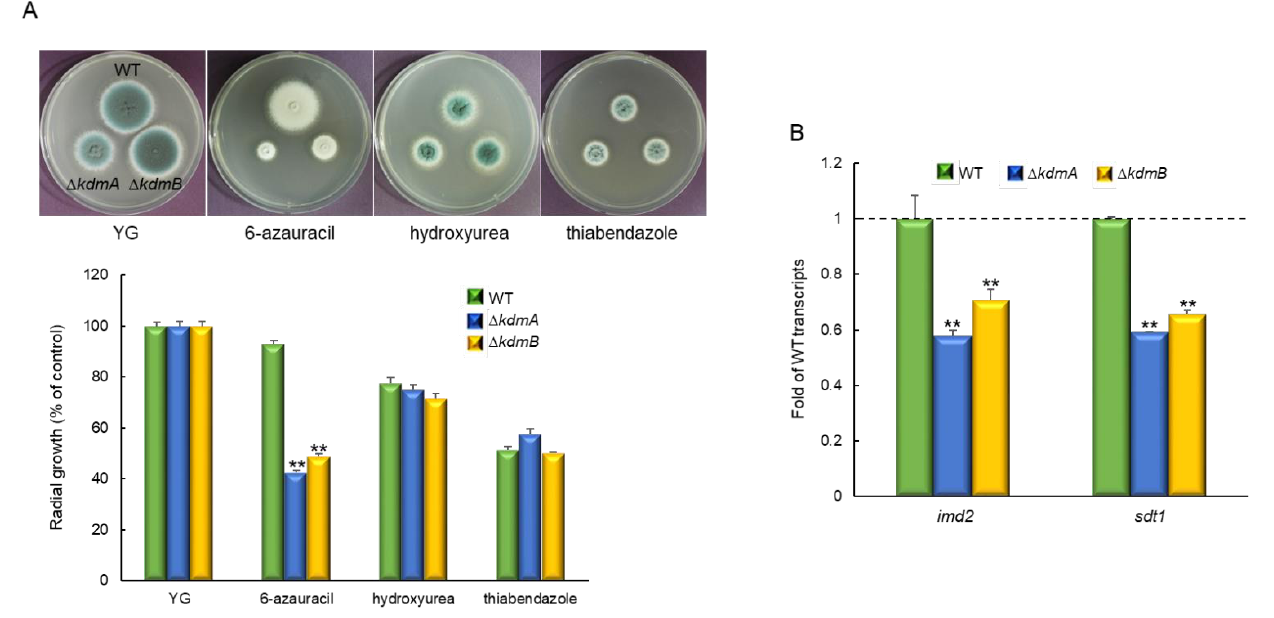
Figure 4. Increased sensitivity of the ∆ kdmA and ∆ kdmB mutants to 6AU. ( A ) Radial growth of the WT and mutant strains in the presence of chromatin-targeting inhibitors. ( B ) RT-qPCR analysis of expression levels of the 6AU resistance-related genes imd2 and sdt2 in the WT and mutant strains in the presence of 100 μ g/mL of AU. Dot line indicates the level of WT transcript. Statistical significance of differences between WT and mutant strains was evaluated using Student’s t -test: ** p < 0.01.